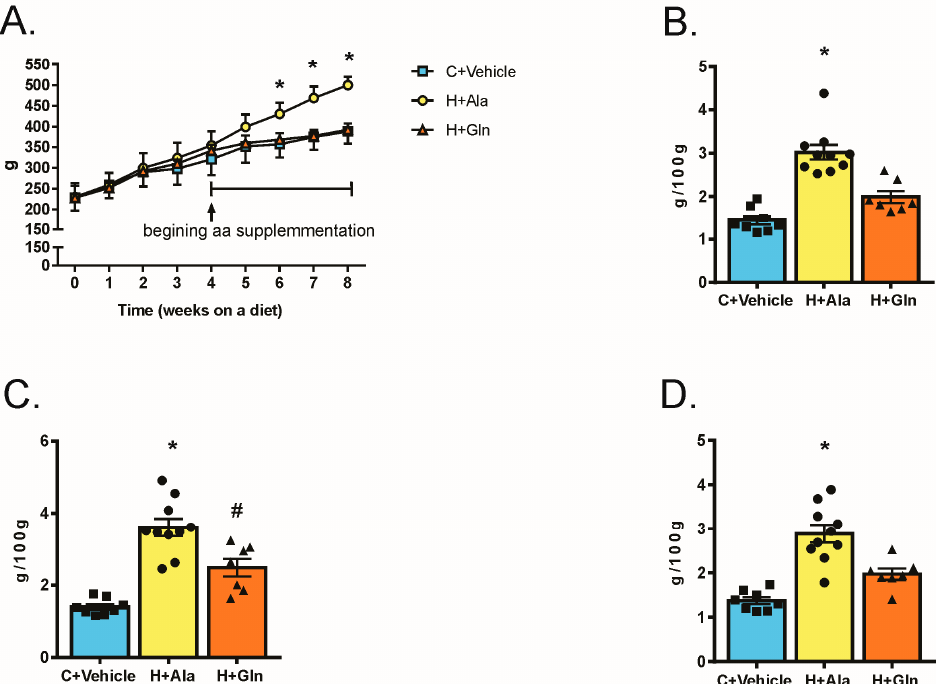
Figure 2. Body Weight (BW) during 8-weeks of amino acids or vehicle (water) supplementation via gavage started at 4-weeks ( A ), epididymal fat mass ( B ), retroperitoneal fat mass ( C ), and mesenteric fat mass ( D ). Rats that received chow diet and vehicle (C+Veh, n = 8), rats fed with a high fat diet and supplemented with Alanina (H+Ala, n = 10) and rats fed with a high-fat diet and supplemented with glutamine (H+Gln, n = 7). Values were displayed as mean ± SEM. Two-Way-ANOVA with a Bonferroni post-test was used in ( A ). One-Way-ANOVA with a Bonferroni post-test that was used in ( B – D ). * p < 0.05 vs. C+Veh and vs. H+Gln. # p < 0.05 vs.